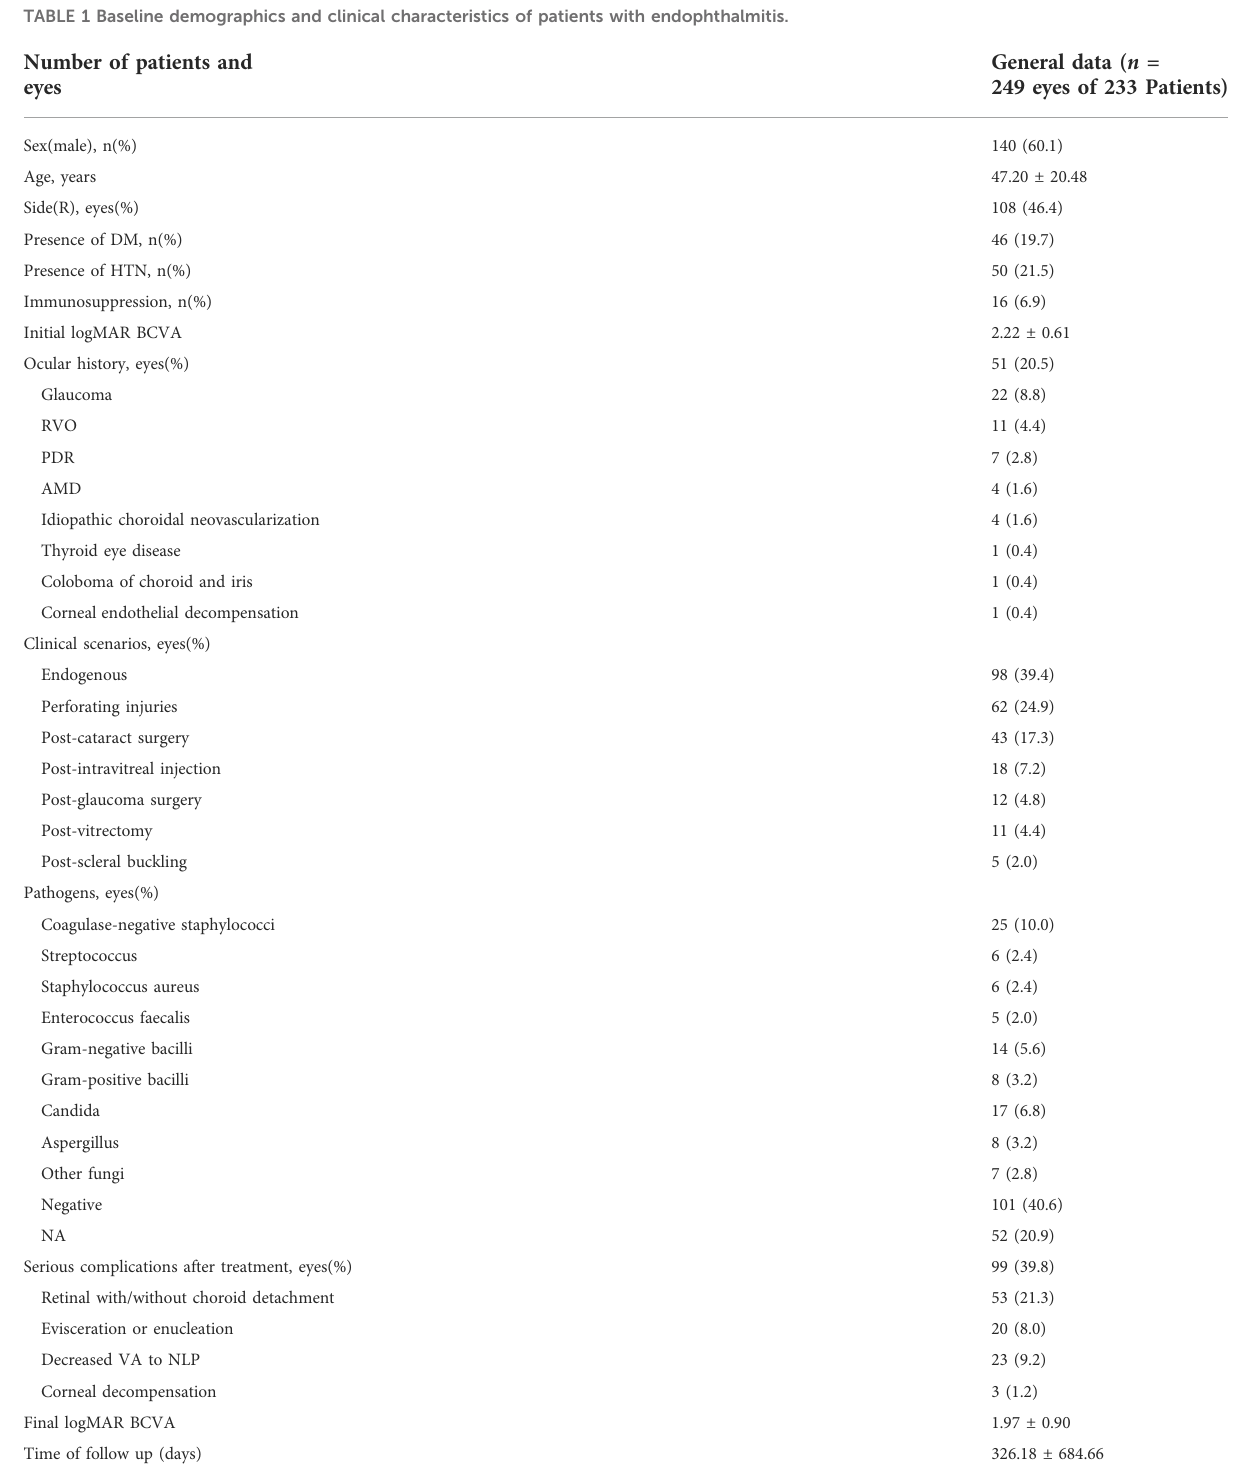
TABLE 1 Baseline demographics and clinical characteristics of patients with